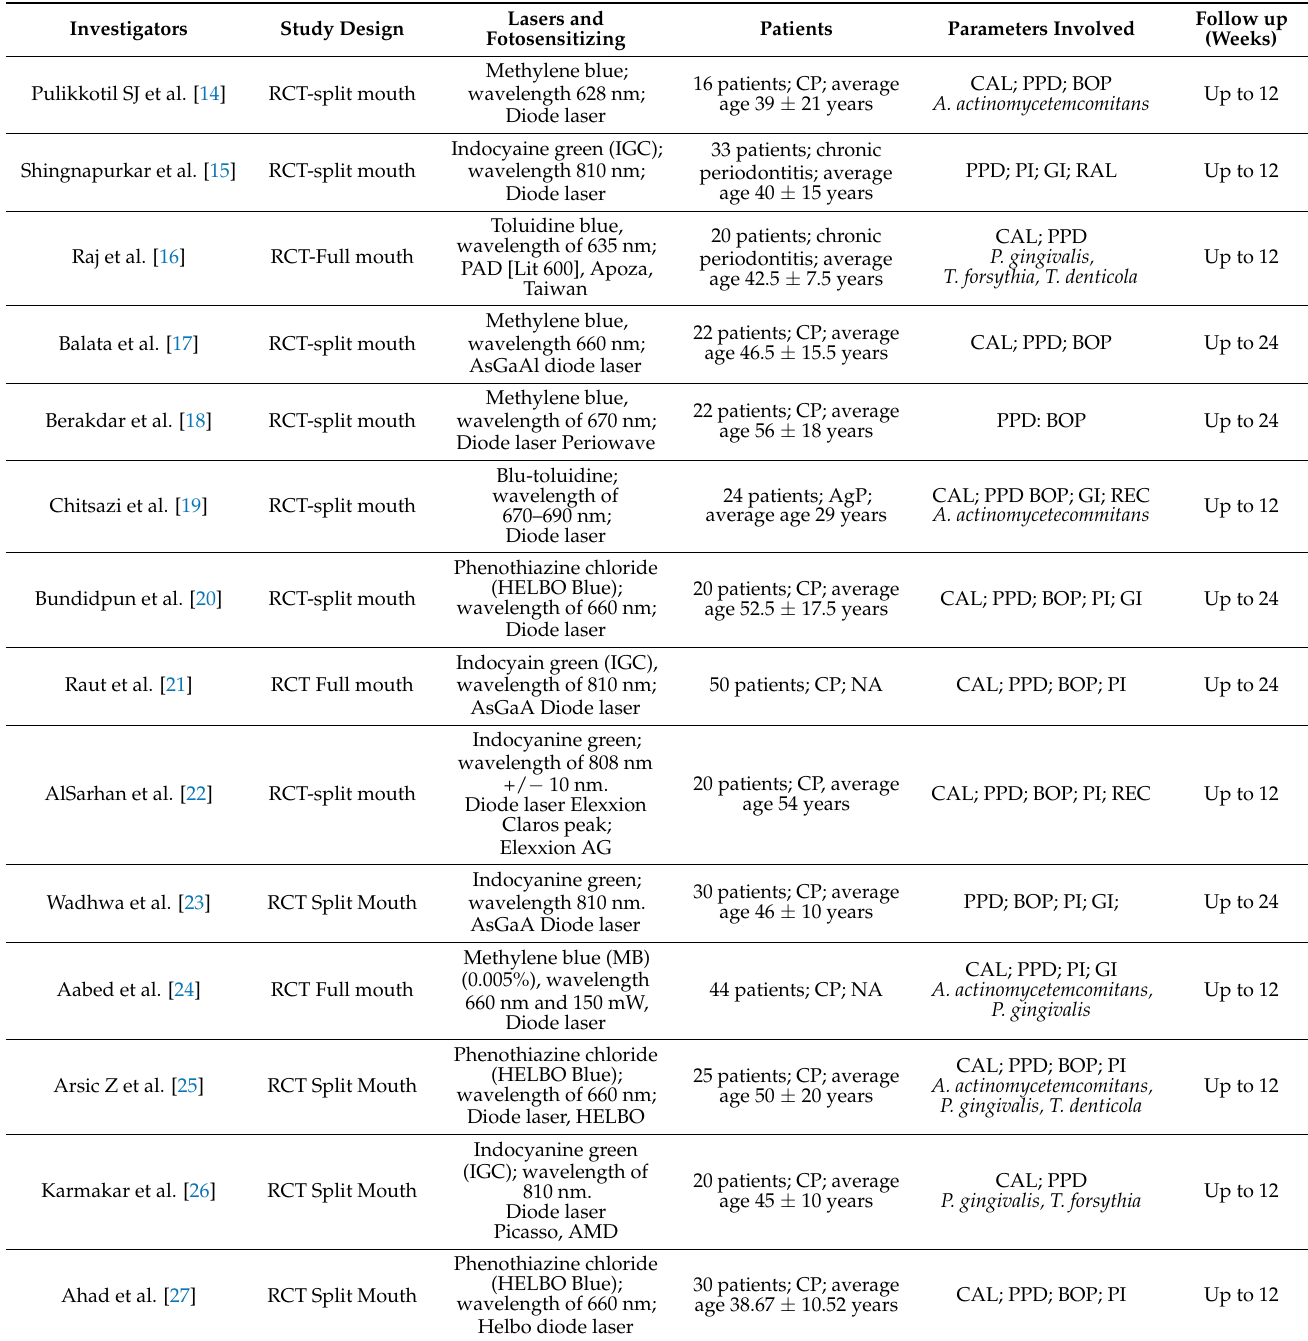
Table 1. General characteristics of included